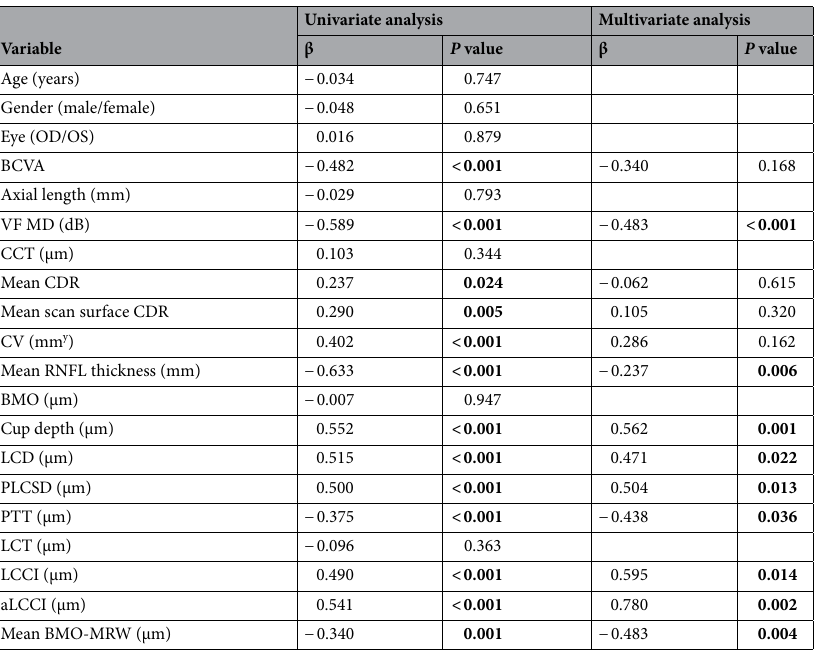
Table 3. Linear regression relationship between IOP and factors. aLCCI = adjusted lamina cribrosa curvature index; BCVA = best-corrected visual acuity; BMO = Bruch’s membrane opening; BMO-MRW = Bruch’s membrane opening minimum rim width; CCT = central corneal thickness; CDR = cup-disk ratio; CV = cup volume; IOP = intraocular pressure; LCCI = lamina cribrosa curvature index; LCD = lamina cribrosa depth; LCT = lamina cribrosa thickness; MD = mean deviation; PLCSD = posterior lamina cribrosa surface depth; PTT = prelaminar tissue thickness; RNFL = retinal nerve fiber layer; VF = visual field. Statistical analysis was performed using the general linear model. Statistically significant values are shown in boldface. Factors with P < 0.1 in the univariate analysis were included from the multivariate analysis. All values < 0.05 at univariate and multivariate analysis are presented in boldface.